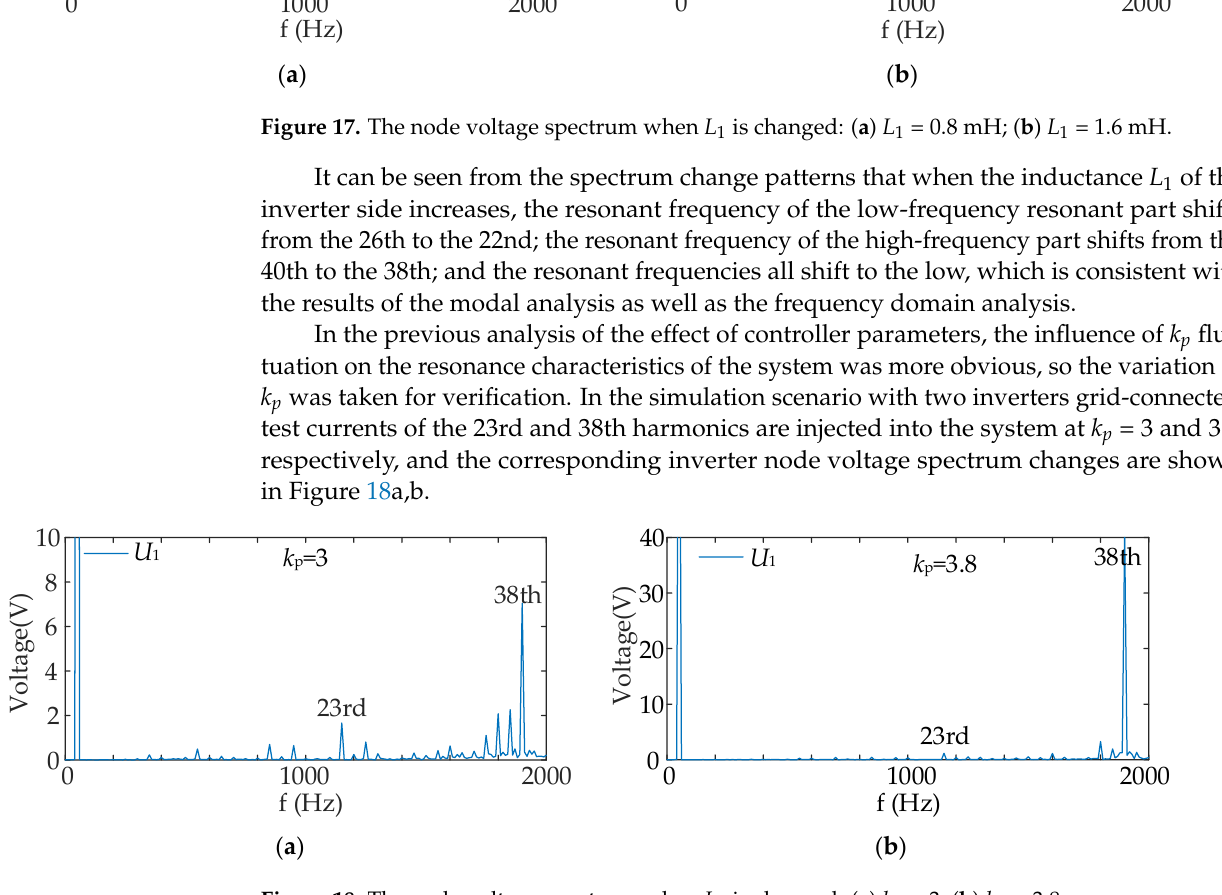
Figure 18. The node voltage spectrum when L 1 is changed: ( a ) k p = 3; ( b ) k p = 3.8. It can be seen from the spectrum change patterns that when the inverter current con- troller parameter k p is increased, the resonant frequencies of the low-frequency resonance and high-frequency parts do not change, and the resonant amplitude of the high-frequency part increases significantly, and the harmonic content increases, which exacerbates the resonance risk, in accordance with the results of the modal analysis as well as the frequency domain analysis.